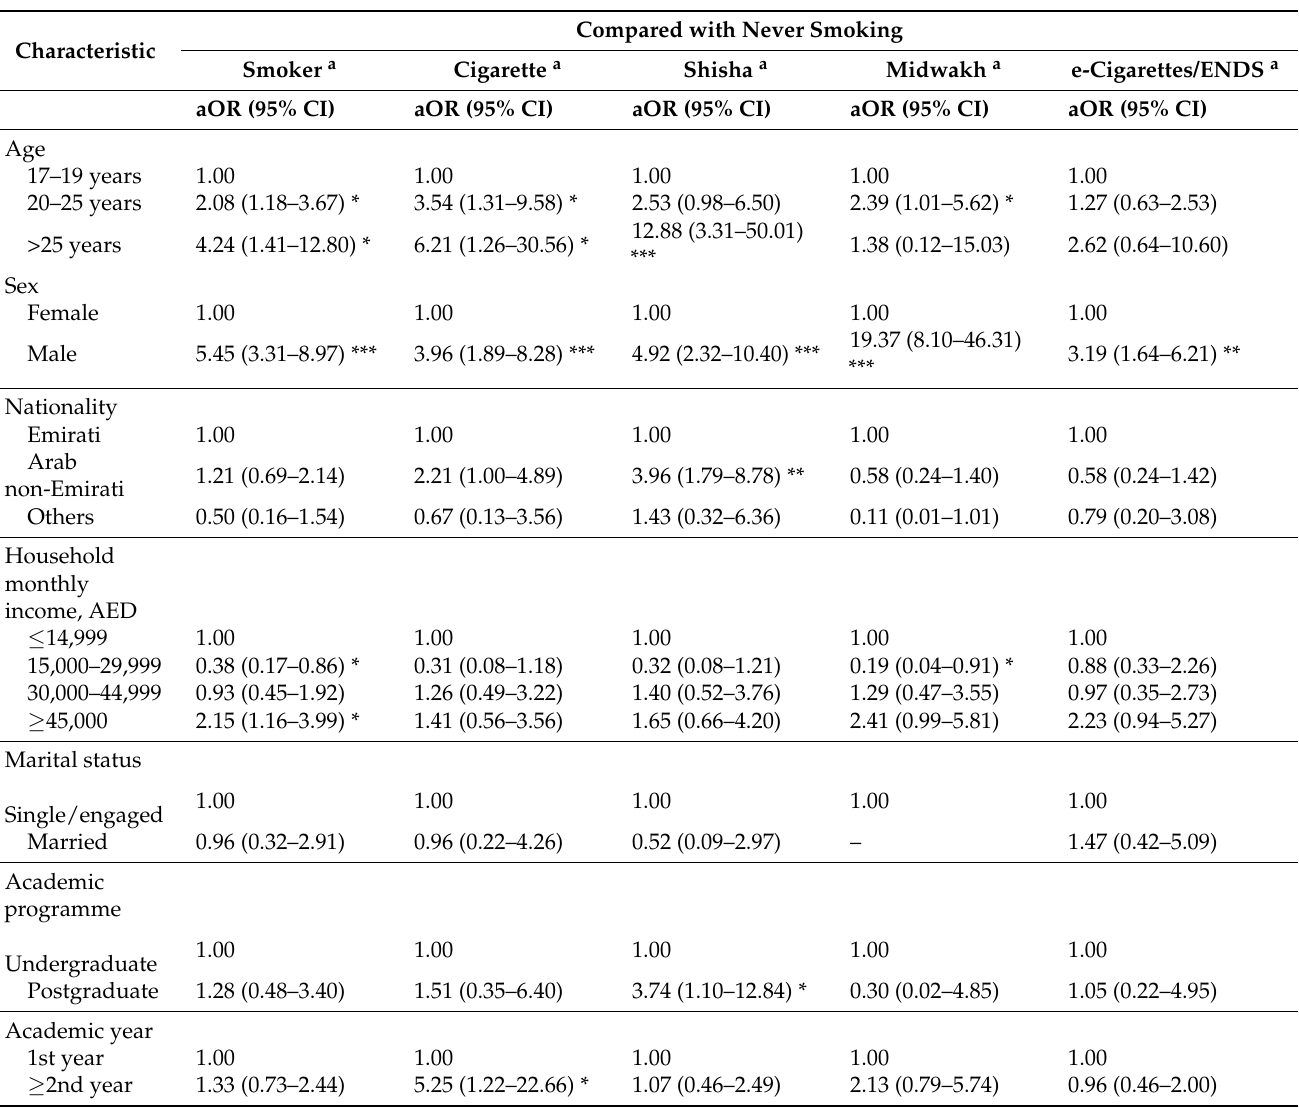
Table 3. Adjusted associations between sociodemographic and academic characteristics and different patterns of smoking e-cigarette/ENDS